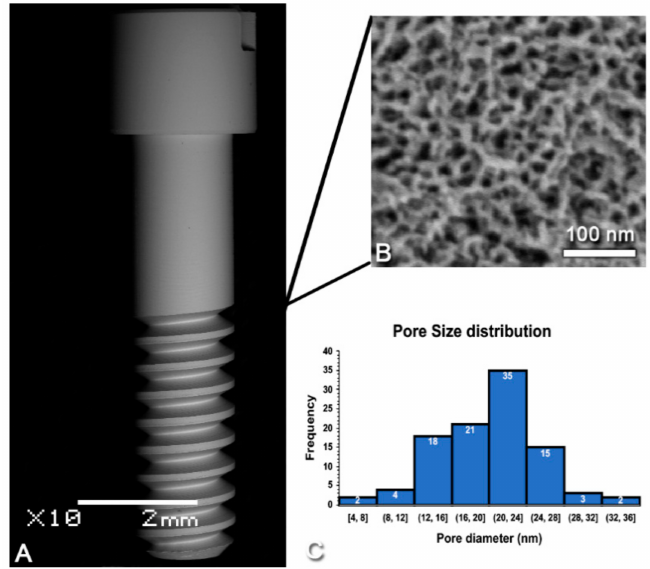
Figure 2. Scanning electron micrographs of ( A ) the screw-shaped implant used and ( B ) the nanoporous topography created by oxidative nanopatterning. ( C ) Size distribution of the nanopores ( n =